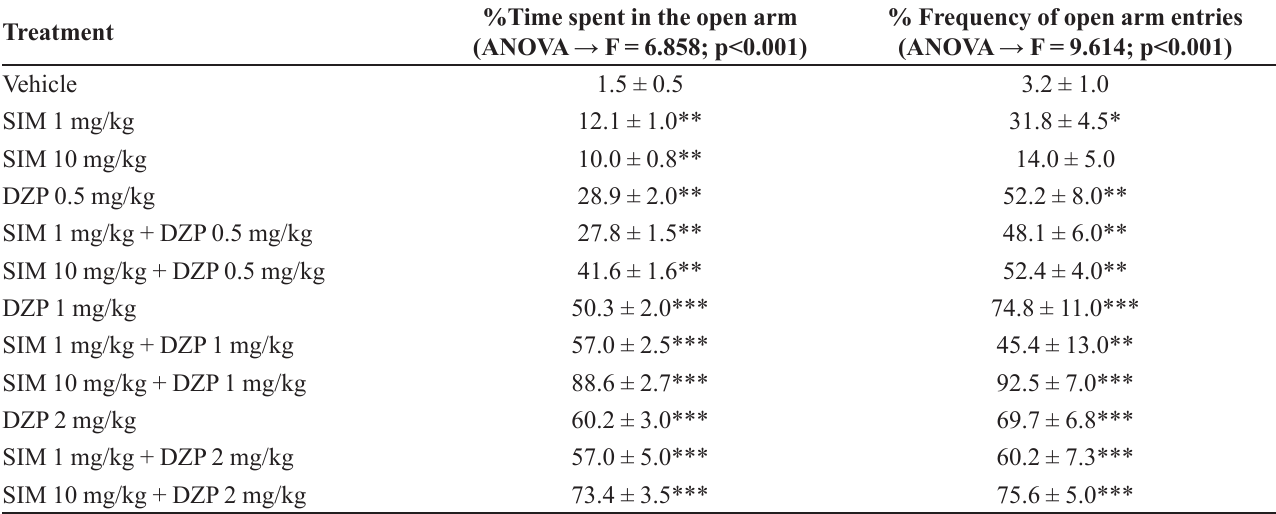
Source: (Pauleti et al. ,